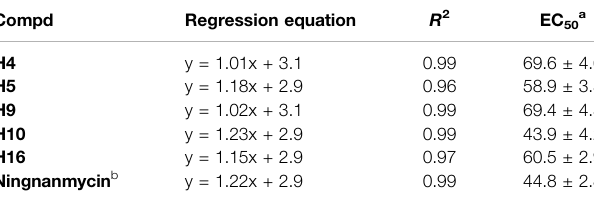
TABLE 6 | EC 50 of inactivation activity of some target compounds against